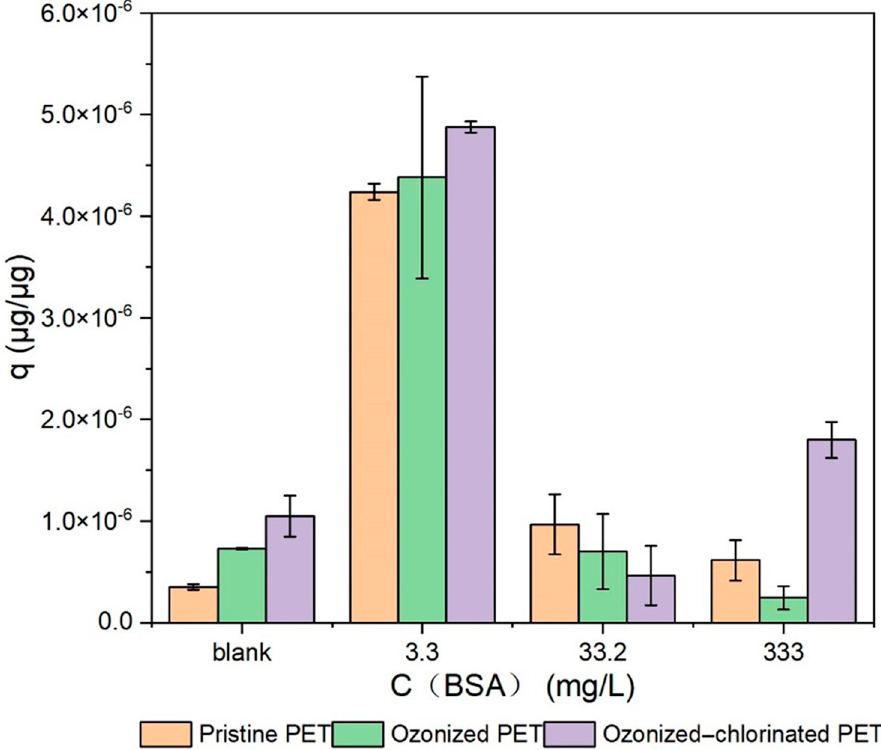
Figure 10. The influence of BSA on TBM sorption to PET with the different oxidation